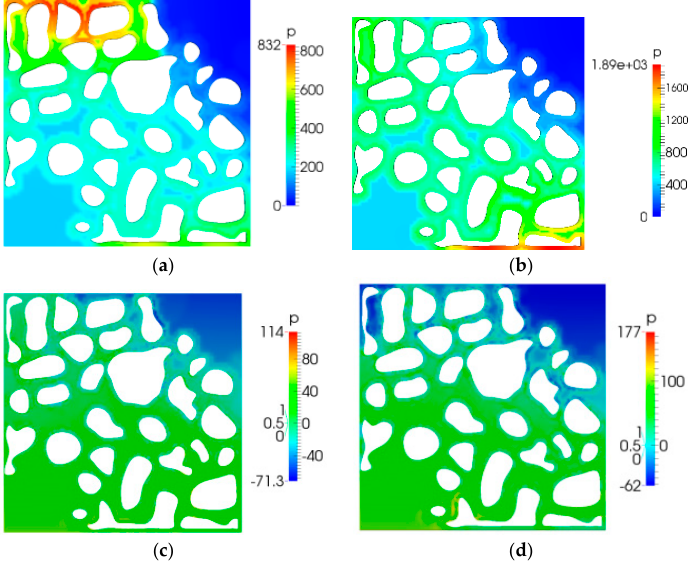
Figure 10. Displacement fluid front breakthrough times: ( a ) 15 s; ( b ) 16 s; ( c ) 19 s; and ( d ) 21 s. On the basis of the pressure distribution, the pressure drop between inlet and outlet versus time is plotted in Figure 11. As can be seen, the pressure drop increased until the displacement fluid broke in the outlet.